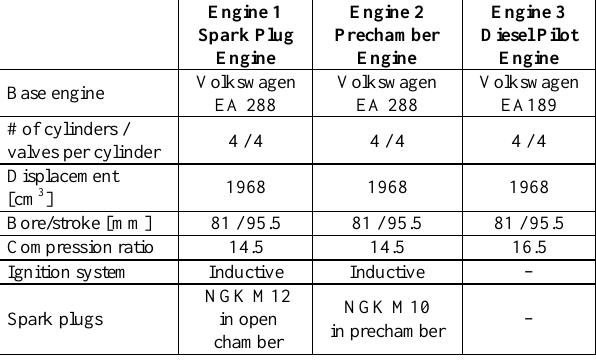
Table 1. Main characteristics of the used